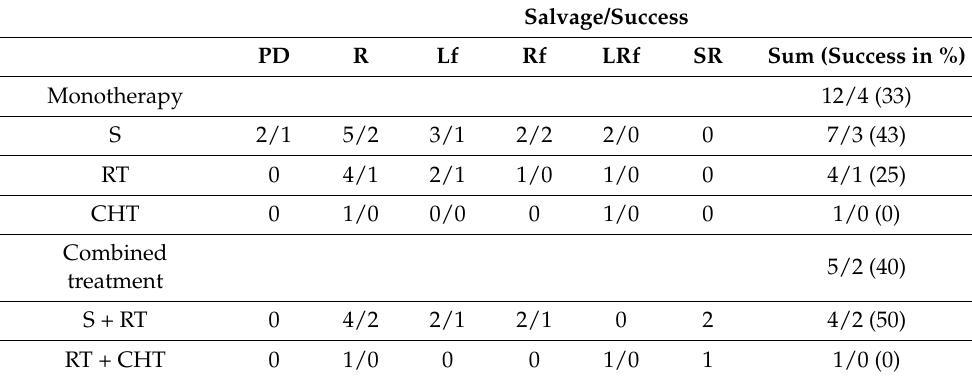
Table 2. Ratio of salvage and its effectiveness according to the category of primary treatment failure and the type of salvage. PD—persistent disease, R—recurrence, Lf—local failure, Rf—regional failure, LRf—local and regional failure, SR—subsequent recurrence, S—surgery, RT—radiotherapy, and